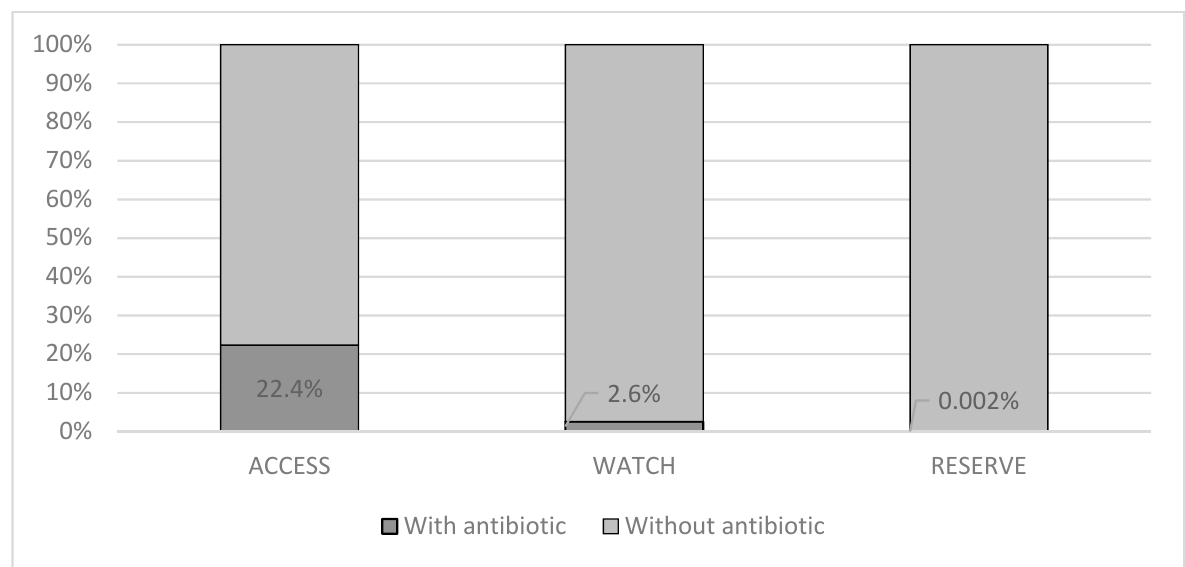
Figure 1. Proportion of antibiotic use according to the most frequent diagnoses in patients with viral respiratory tract infections, Colombia—2018.